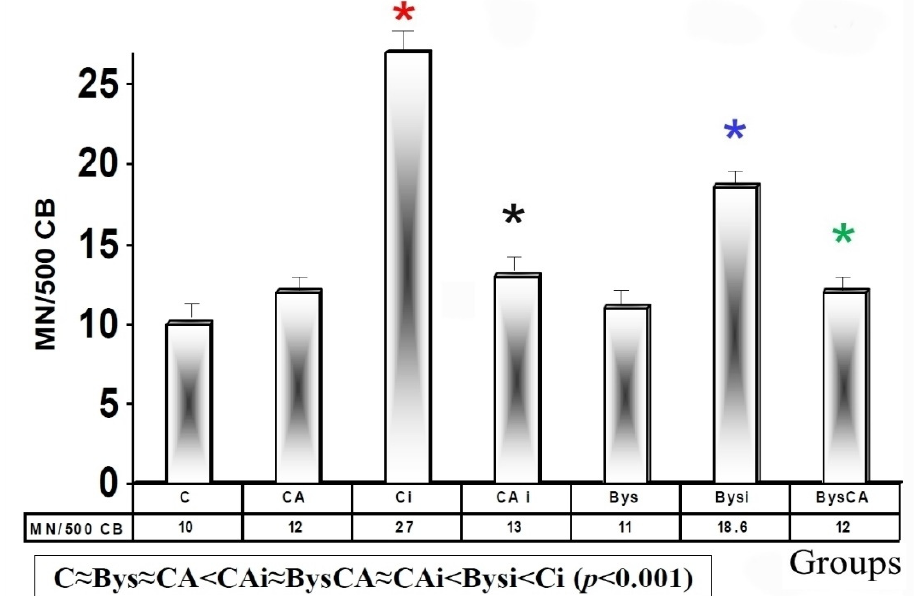
Figure 5. Frequency of micronuclei in cytokinesis-blocked human lymphocytes (CBMN) (C, control; CA, treated with carnosic acid; Ci, irradiated control; CAi, irradiated previously treated with carnosic acid; Bys, treated with serum non irradiated; Bysi, treated with serum previously irradiated; BysCA, treated with irradiated serum previously treated with carnosic acid) ( * p < 0.001 versus C; * p < 0.001 versus Ci; * p < 0.01 versus Ci; * p < 0.01 versus Bysi).